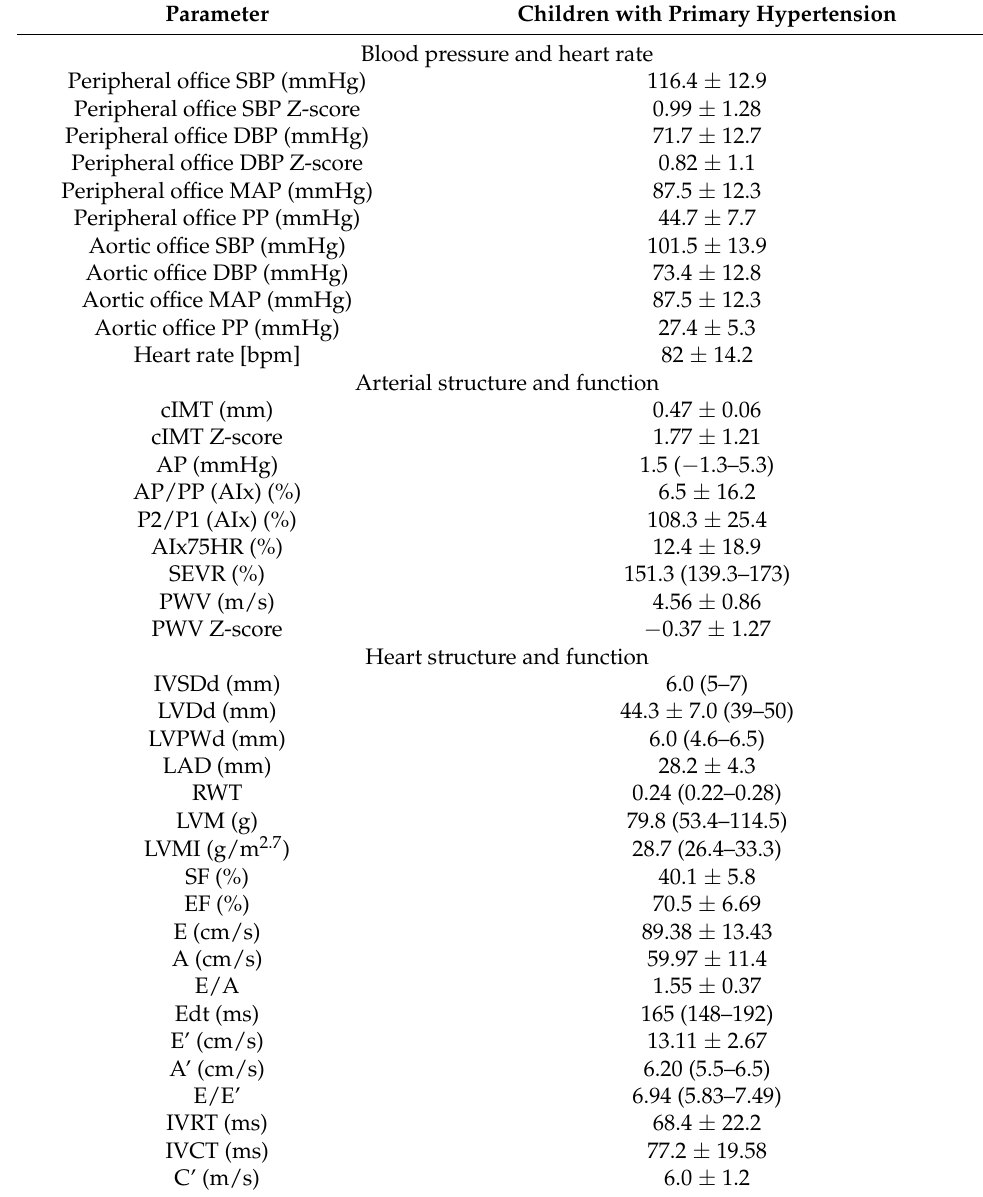
Table 3. Blood pressure, arterial, and heart parameters in the study